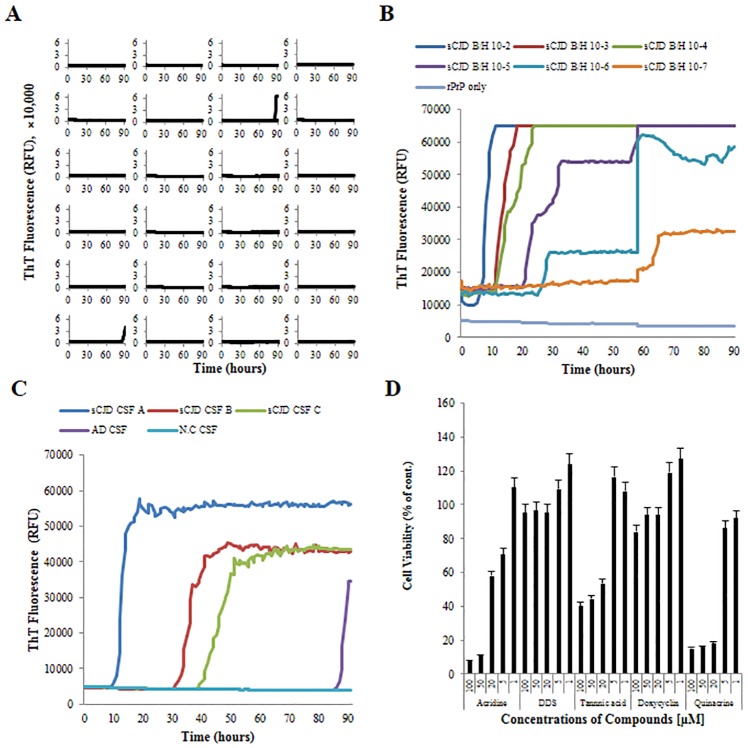
Optimization of RT-QuIC and determination of compound cytotoxicity.Time point optimization was performed using CSF samples from 24 cases of progressive dementia (A) and validation was performed using serially diluted sCJD brain homogenate (B) and CSF from a sCJD or AD patient (C). Cell viability was assessed in the presence of 5 different compounds at 5 different concentrations between 1 μM and 100 μM (D). Values represent the mean of 3 independent experiments and the standard deviation is shown as error bars, P < 0.05.